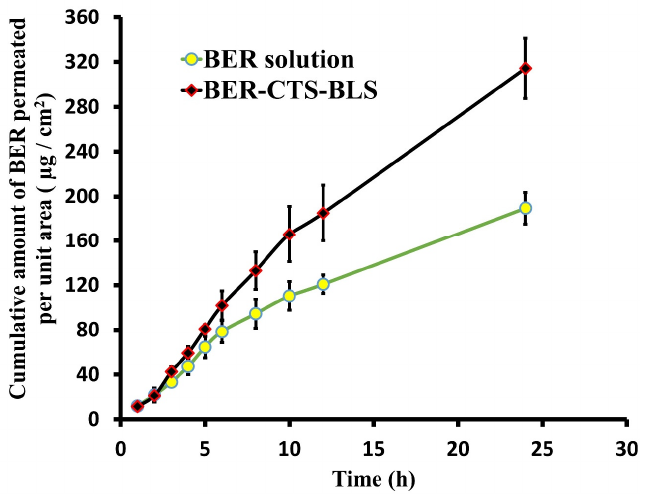
Figure 3. Ex vivo permeation of berberine from BER-CTS-BLS (optimal formula) and BER solution through rat skin. Table 5. Ex vivo permeation parameters of BER-CTS-BLS and BER solution. Cumulative BER Formulation